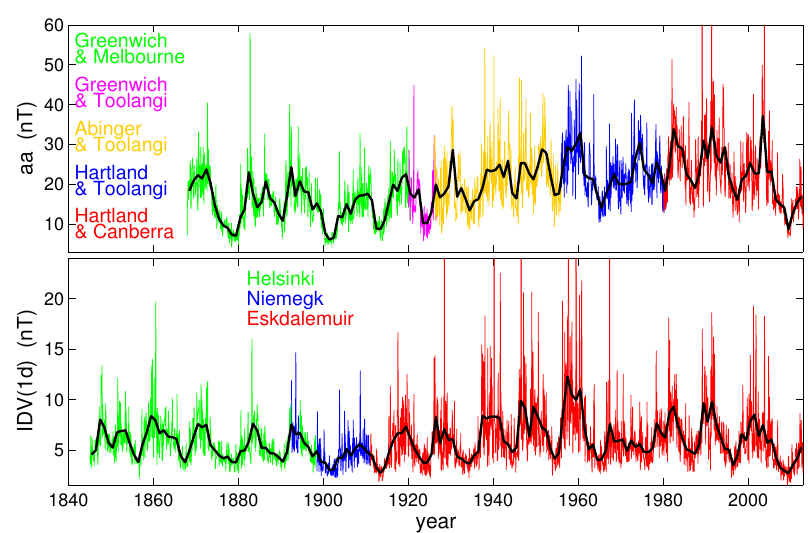
Figure 4: Averages over Bartels 27-day solar rotation intervals (coloured) and calendar years (in black) of (top) the 𝑎𝑎 geomagnetic index and (bottom) the 𝐼𝐷𝑉 (1 𝑑 ) index. The colours give the station(s) contributing the data to the indices at any one time. This version of the 𝑎𝑎 index is as stored in the World Data Centres. The data labelled Niemegk are a composite from the three nearby stations, Niemegk, Potsdam, and